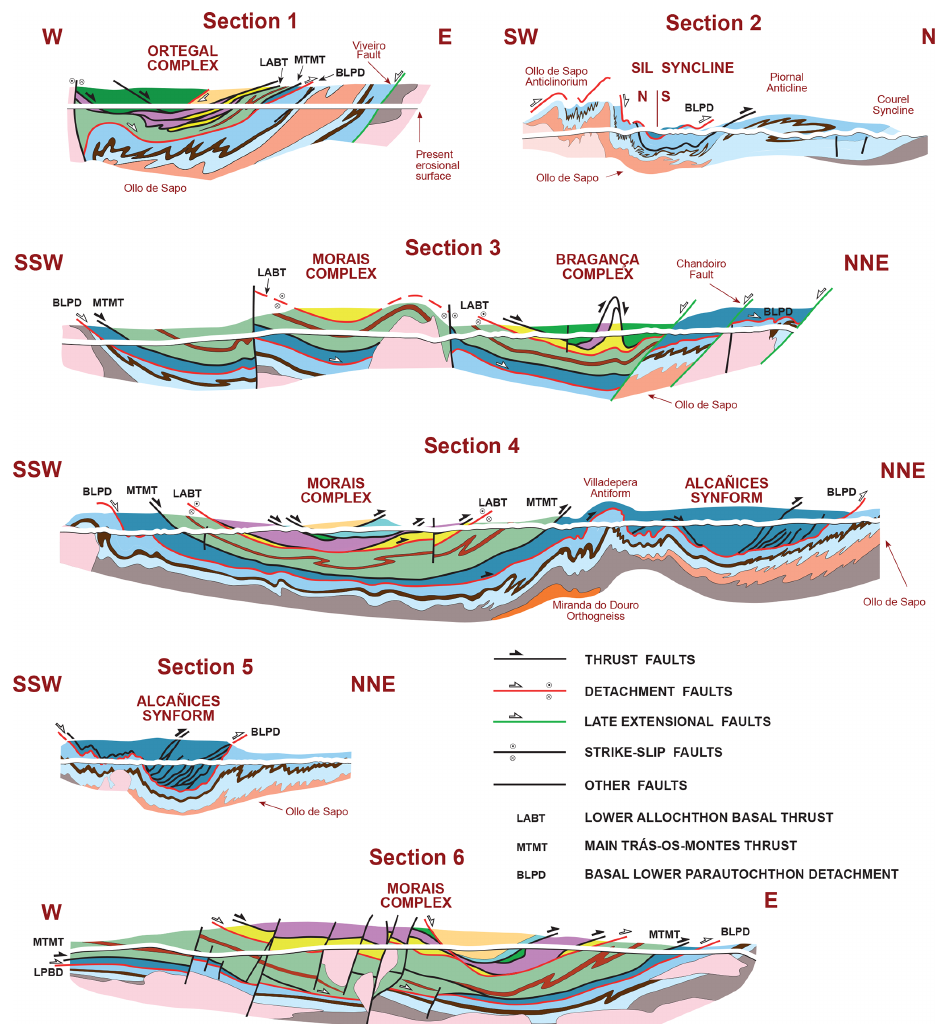
Figure 3. Representative cross sections of the Variscan belt in the region studied including the inferred geometry of the synorogenic tectonic carpet as proposed in this study. See Fig. 2 for location and legend. Cross sections modified from (1) Marcos et al. (1984), Arenas (1988); (2) Martínez Catalán et al. (2004); (3) Pereira et al. (2006), Ribeiro (1974), Díez Montes (2006); (4) Pereira et al. (2006), Ribeiro (1974), González Clavijo and Martínez Catalán (2002); (5) González Clavijo and Martínez Catalán (2002); and (6) Pereira et al. (2006), Dias da Silva